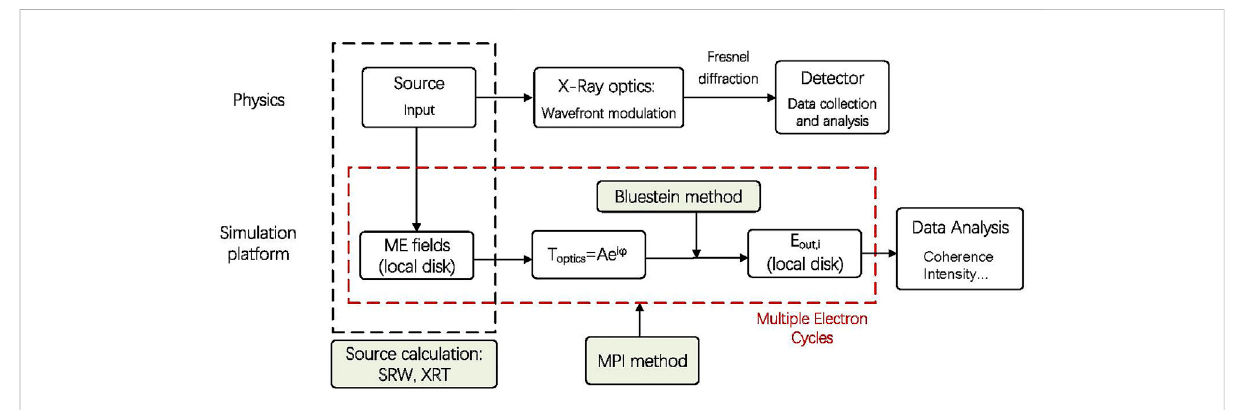
2) Optical wave propagation. Bluestein algorithm[16,17] is used to accelerate the Fresnel diffraction calculation. It can avoid the sampling issue in the traditional fast Fourier transform process.